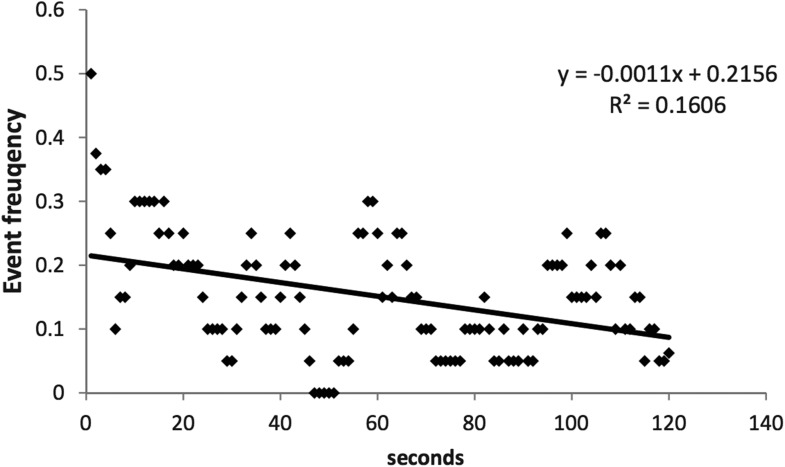
DOI:
http://dx.doi.org/10.7554/eLife.09262.014